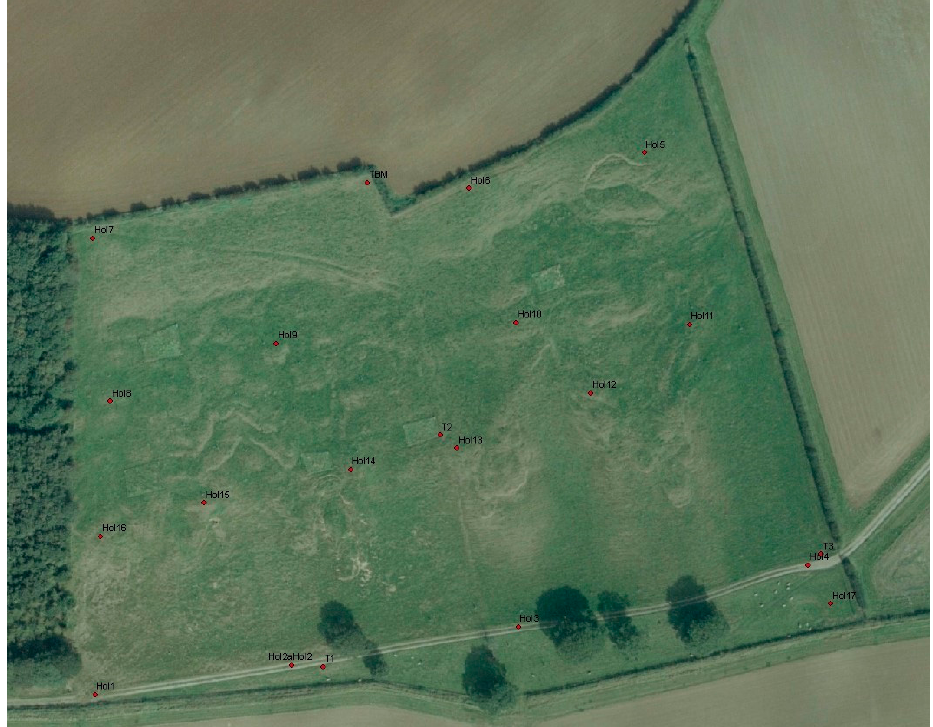
Figure 12. Aerial photograph of the Hollin Hill landslide; fence boundaries show lateral landslide extent.